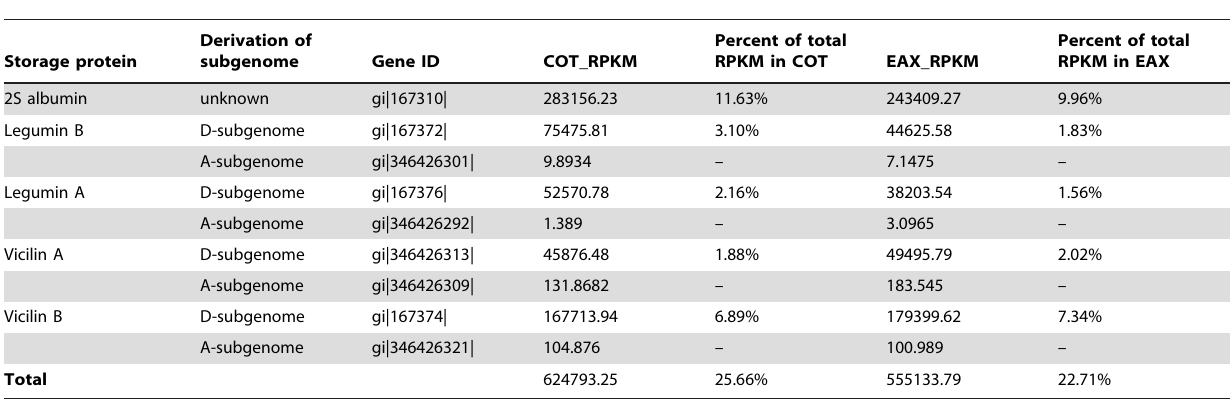
Table 2. The summary of comparative transcriptome analysis of seed storage proteins.